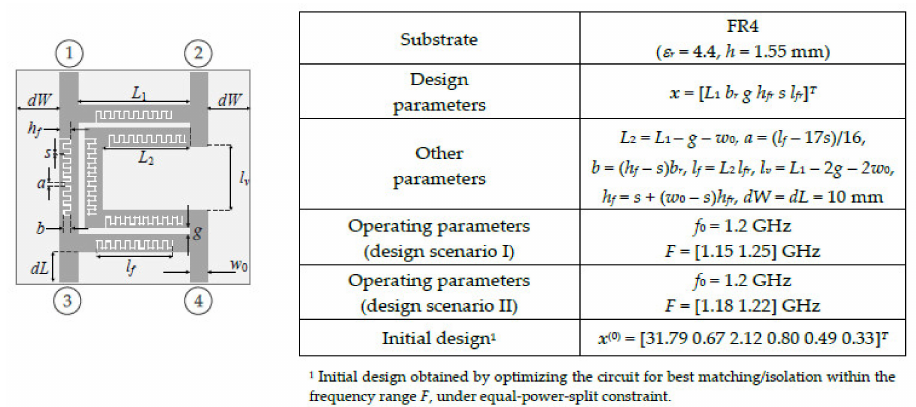
Figure 13. Rat-race coupler [58]: ( a ) geometry, ( b ) essential parameters. The circuit size was optimized using the procedure of [43], and the algorithm used the implicit approach with a number of combinations of the penalty coefficients. The termina- tion threshold is set to ε = 10 − 3 , the acceptance thresholds are chosen to be G 1.max = 1 dB, G 2.max = 0.3 dB, and α = 0.1.